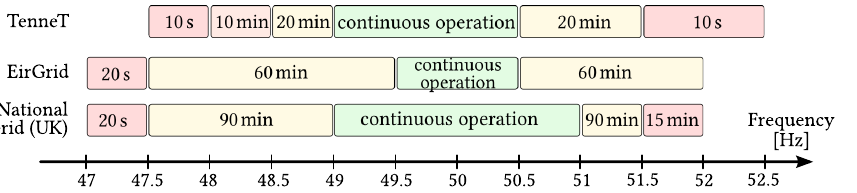
Figure 4. Comparison of maximum times of operation as a function of grid frequency required by TenneT, the Grid Code of Ireland and the National Grid Code (UK).